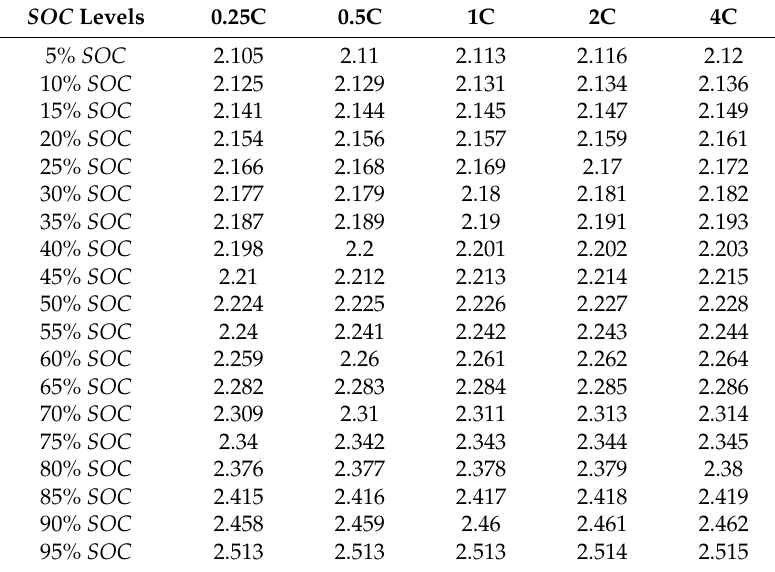
Figure 2. OCV and SOC characteristic at 30 °C. Table 2. 2-D lookup table for determination of OCV .